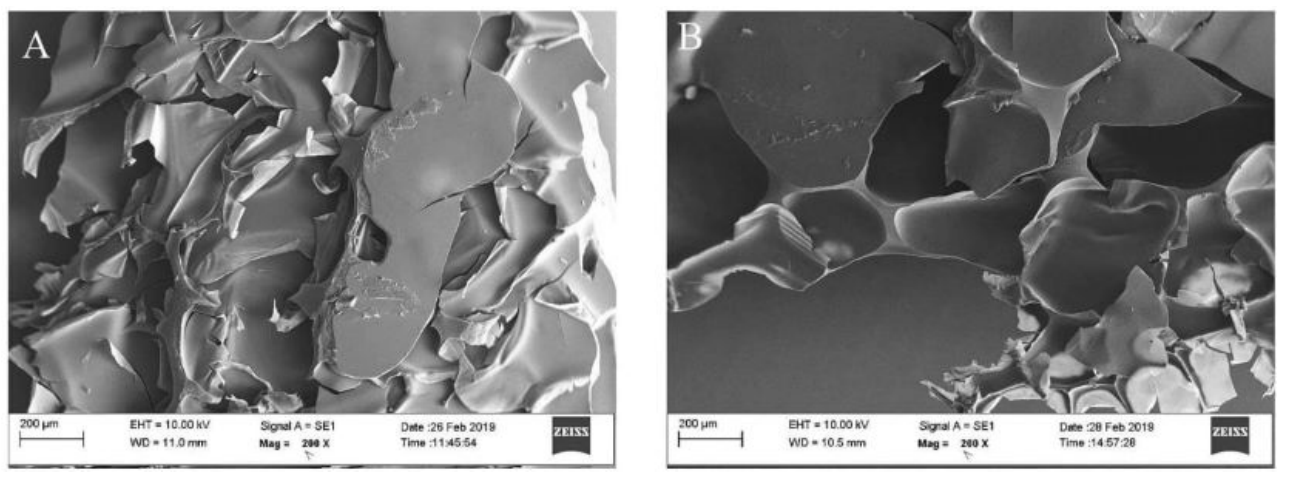
FIGURE 1 - Scanning electron photomicrographs of chitosan-PVA hydrogel surface morphology (A: B1 formulation, B: F2